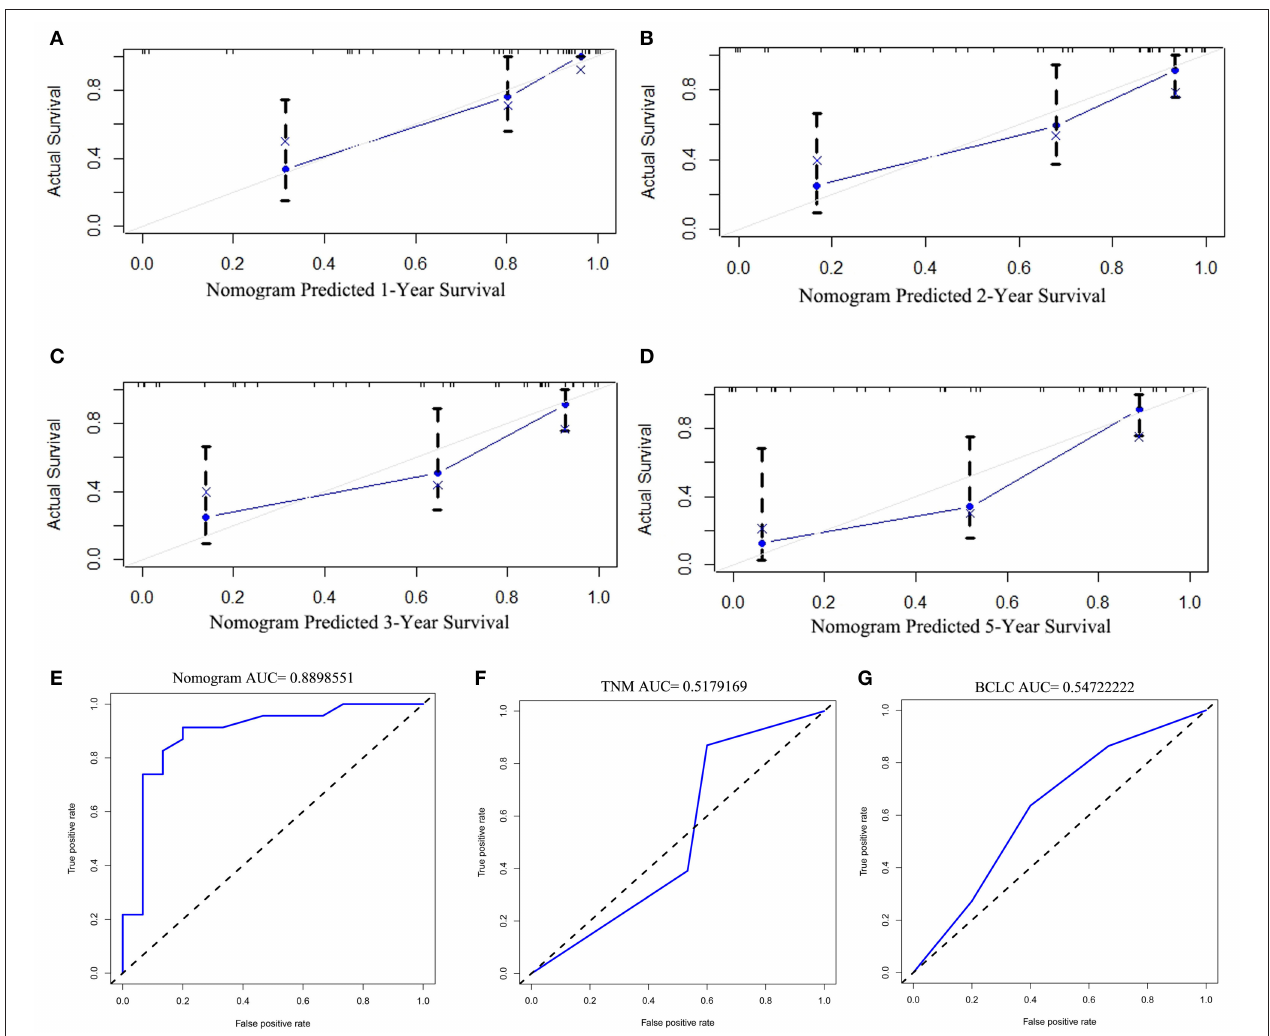
FIGURE 3 | The calibration curve for predicting the 1-, 2-, 3-, and 5- year post-recurrence survival in the training (A–D) cohort; nomogram-predicted probability of PRS is plotted on the x-axis; actual PRS is plotted on the y-axis. The AUC of the nomogram, and the TNM and BCLC stage systems in external validation cohorts (E–G)